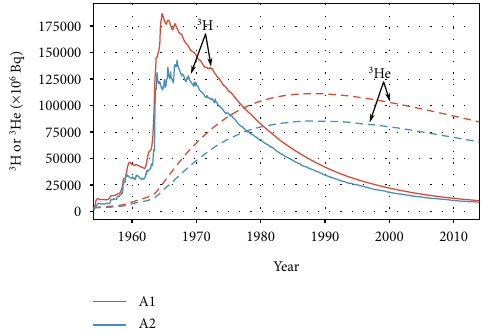
Figure 6: Temporal evolution of the total 3 H in Bq (solid lines) and 3 He (dashed lines) in the freshwater lens (groundwater with less than 2.5% seawater) for simulations A1 (red) and A2